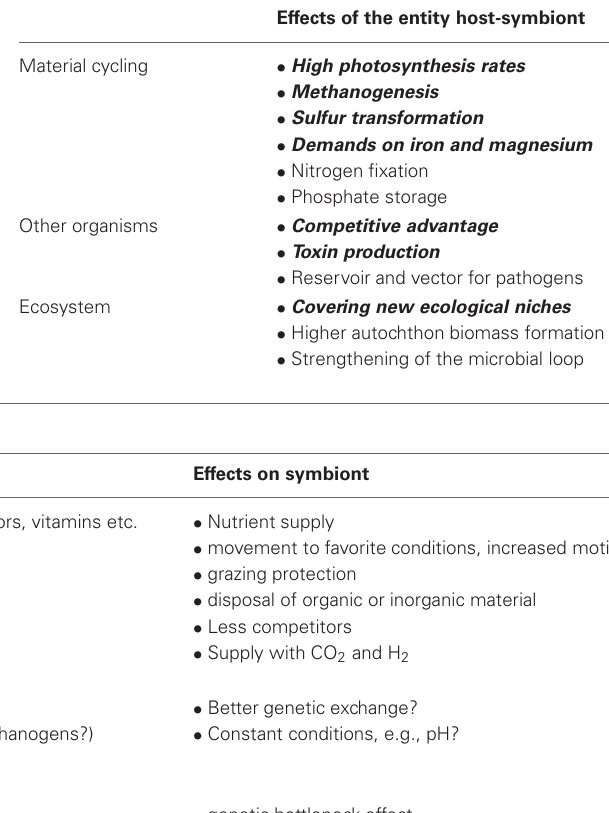
Table 2 | Potential and published ecological consequences of symbioses in aquatic ciliates (for references see text).